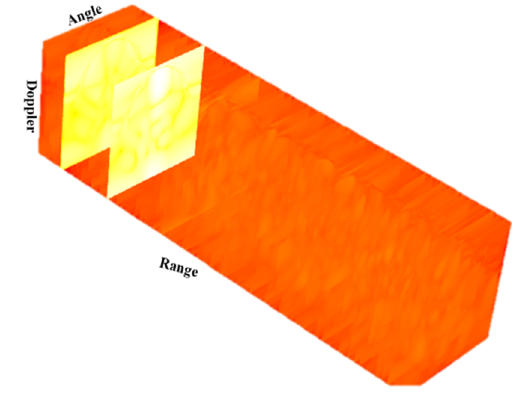
Figure 12. 3D processed data.